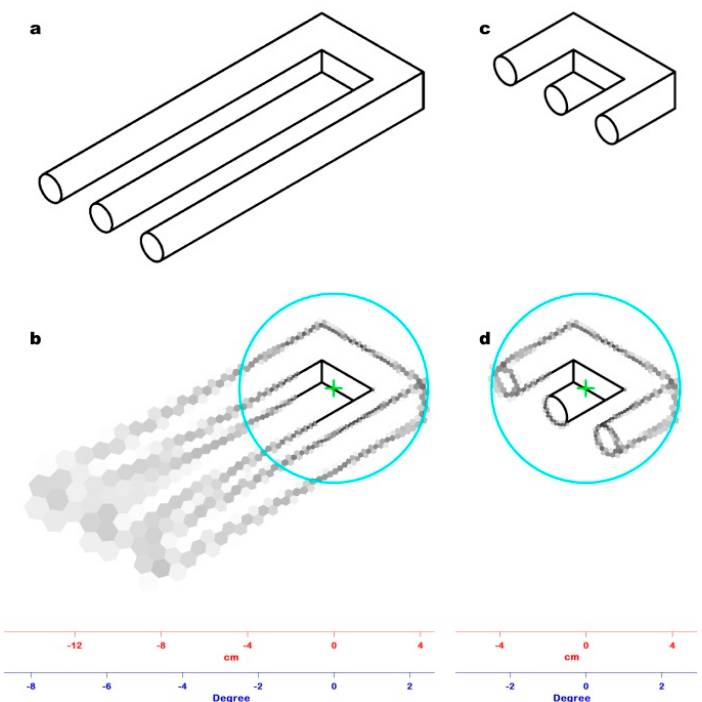
Figure 3. ( a ) The impossible figure used as stimulus in Experiment #2, known as the devil’s pitchfork or Schuster’s conundrum. ( b ) The result of Experiment #2: the tines of the fork have been reduced to the point at which 3D incoherence can be pre-attentively perceived, identifying the corresponding visual angle (2.45°). ( c ) The PRI of the devil’s pitchfork shown in Figure 3a: The fixation point (green cross) was positioned at the base of the tines. The cyan circle marks the limit of the window (42.80 mm radius) in which 3D incoherence can be pre-attentively perceived. Outside the window, the spatial resolution drops, hindering the detection of the image oddity. ( d ) The PRI of the trimmed devil’s pitchfork shown in Figure 3b: the fixation point (green cross) has the same position of Figure 3c. The entire impossible figure is represented within the window (cyan line) in which 3D incoherence can be pre-attentively perceived with minimal loss of spatial resolution, so its oddity is perceived in a single